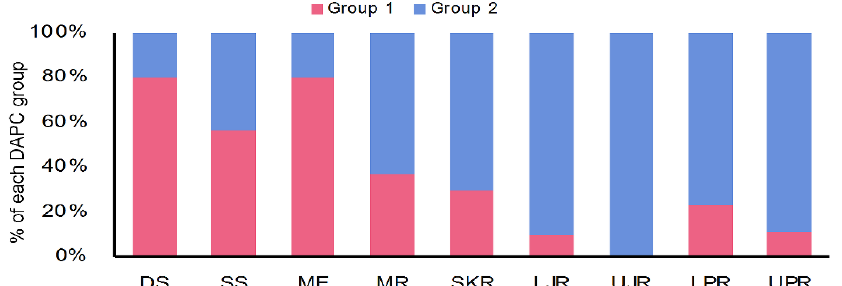
Figure 6. DAPCs grouping of T. ilisha individuals for the putatively adaptive SNPs identified by the pcadapt approach based on the percentages of the each DAPCs clusters according to their different collection sites. The DAPCs grouping of the putatively adaptive panels of SNP loci identified by the pcadapt approach of different Hilsa shad collection sites further confirmed that the marine–estuarine collection sites (DS, SS, and ME) are mostly dominated by individuals of Group 1, whereas all the riverine sites (MR, SKR, LJR, UJR, LPR, and UPR) are mostly dominated by individuals of Group 2. DS, deep sea; SS, shallow sea; ME, Meghna estuary; MR, Meghna river; SKR, Surma–Kushiara river; LPR, lower Padma river; UPR, upper Padma river; LJR, lower Jamuna river; UJR, upper Jamuna river.